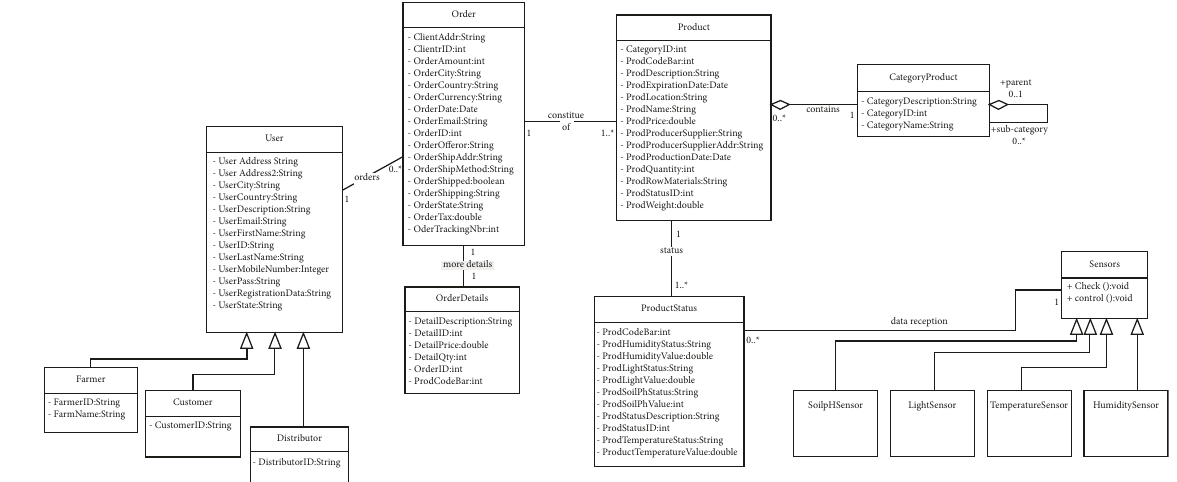
Figure 3: The class diagram of the proposed